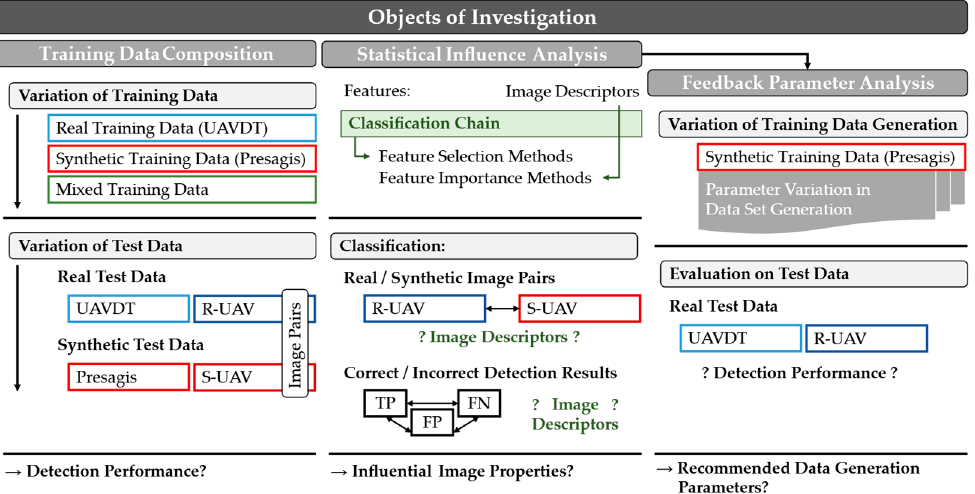
Figure 1. Schematic representation of the focus of investigation in this article, which includes the areas of training data composition, statistical influence analysis, and feedback parameter analysis in training data generation.